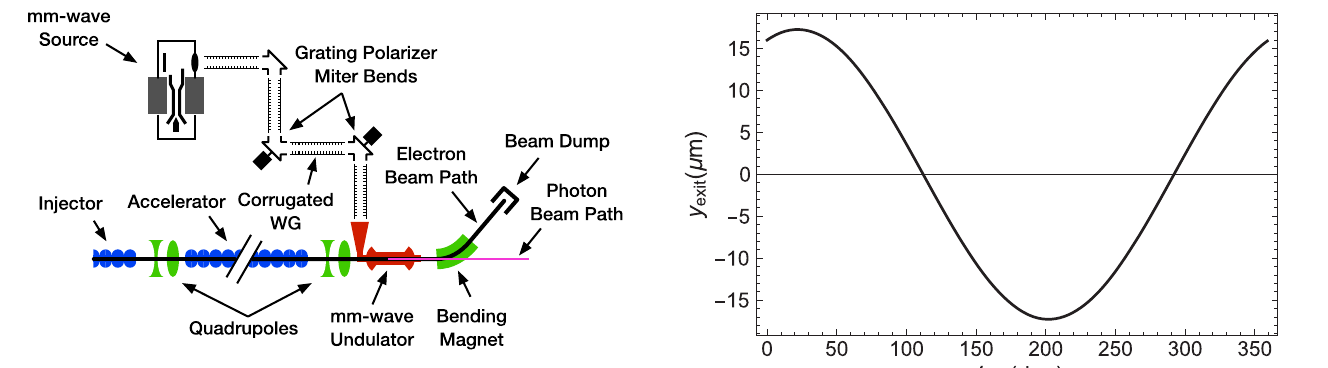
FIG. 28. Light source schematic utilizing the mm-wave undu- latorwithpolarizationcontrol,adaptedfromToufexis etal. [23,31].